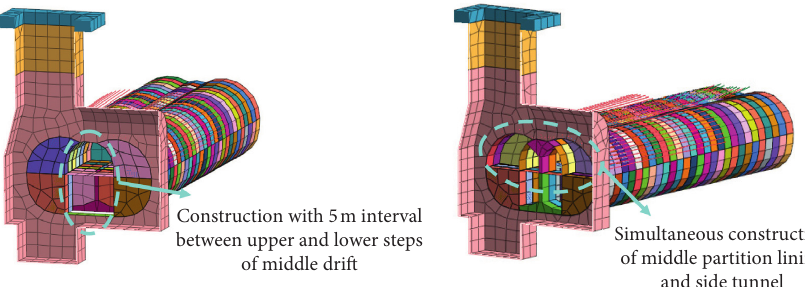
Figure 8: Construction procedure of the original design and construction scheme.